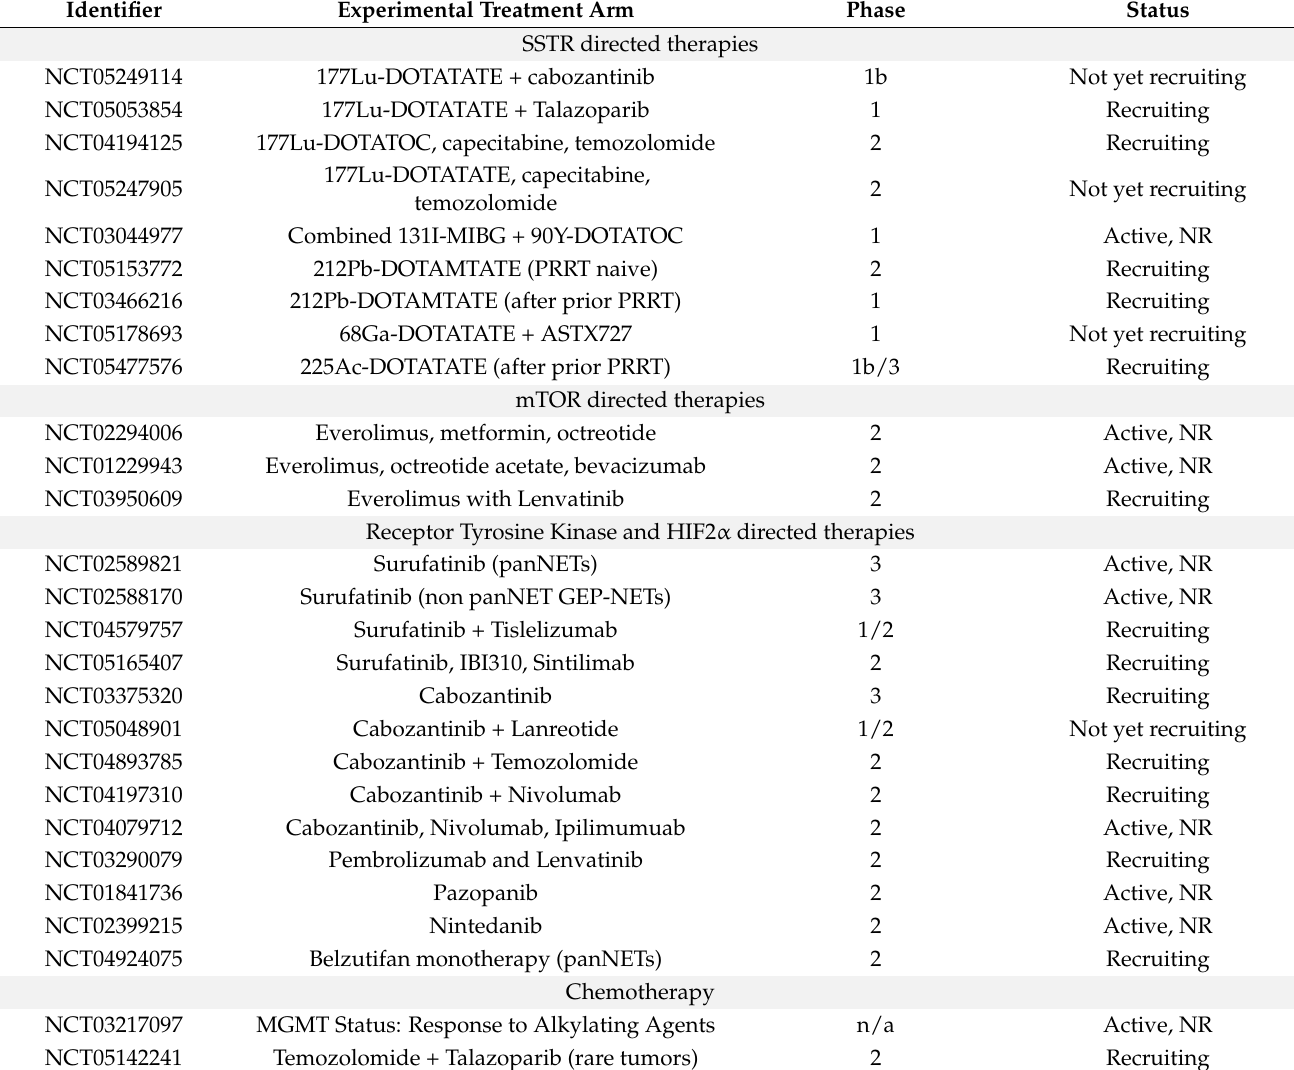
Table 1. Active or planned trials to overcome resistance or optimize anti-tumor response in